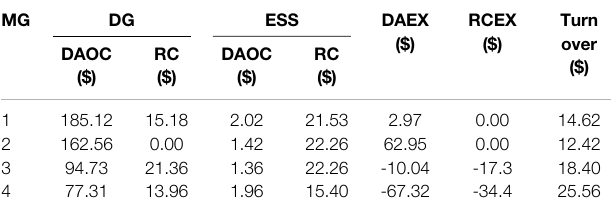
TABLE 3 | Operational cost and RC for the coalition MG (1, 2, 3, 4).